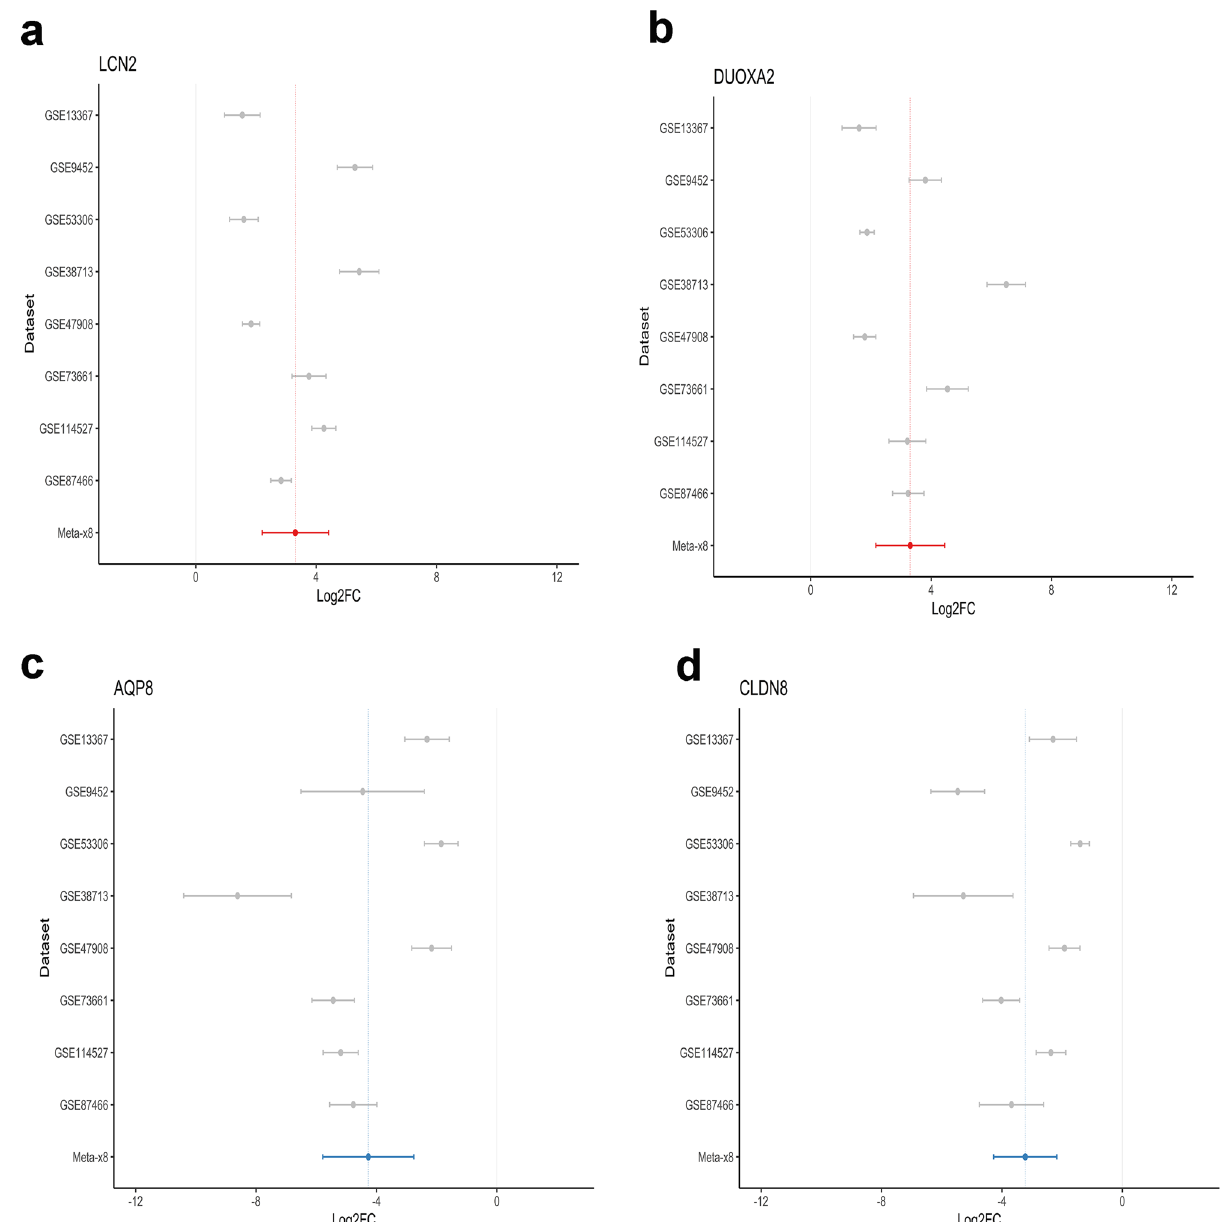
Figure 2. Forest plots of the mean log2 fold changes for the top 2 up-regulated genes identified in meta- analysis, LCN2 (panel a ) and DUOXA2 (panel b ). Data are shown for mean log2 fold changes for each gene in both the individual datasets and for the meta-analysis. The mean log2 fold change for each gene in the meta- analysis is represented by the vertical red dashed line, whereas the mean log2 fold change for the genes in each dataset is represented by grey dots. Whiskers for each mean value correspond to the 95% confidence interval. ( b ) Forest plots of the mean log2 fold changes for the top 2 down-regulated genes identified in meta-analysis, AQP8 (panel c ) and CLDN8 (panel d ). Data are shown for mean log2 fold changes for each gene in both the individual datasets and for the meta-analysis. The mean log2 fold change for each gene in the meta-analysis is represented by the vertical red dashed line, whereas the mean log2 fold change for the genes in each dataset is represented by grey dots. Whiskers for each mean value correspond to the 95% confidence